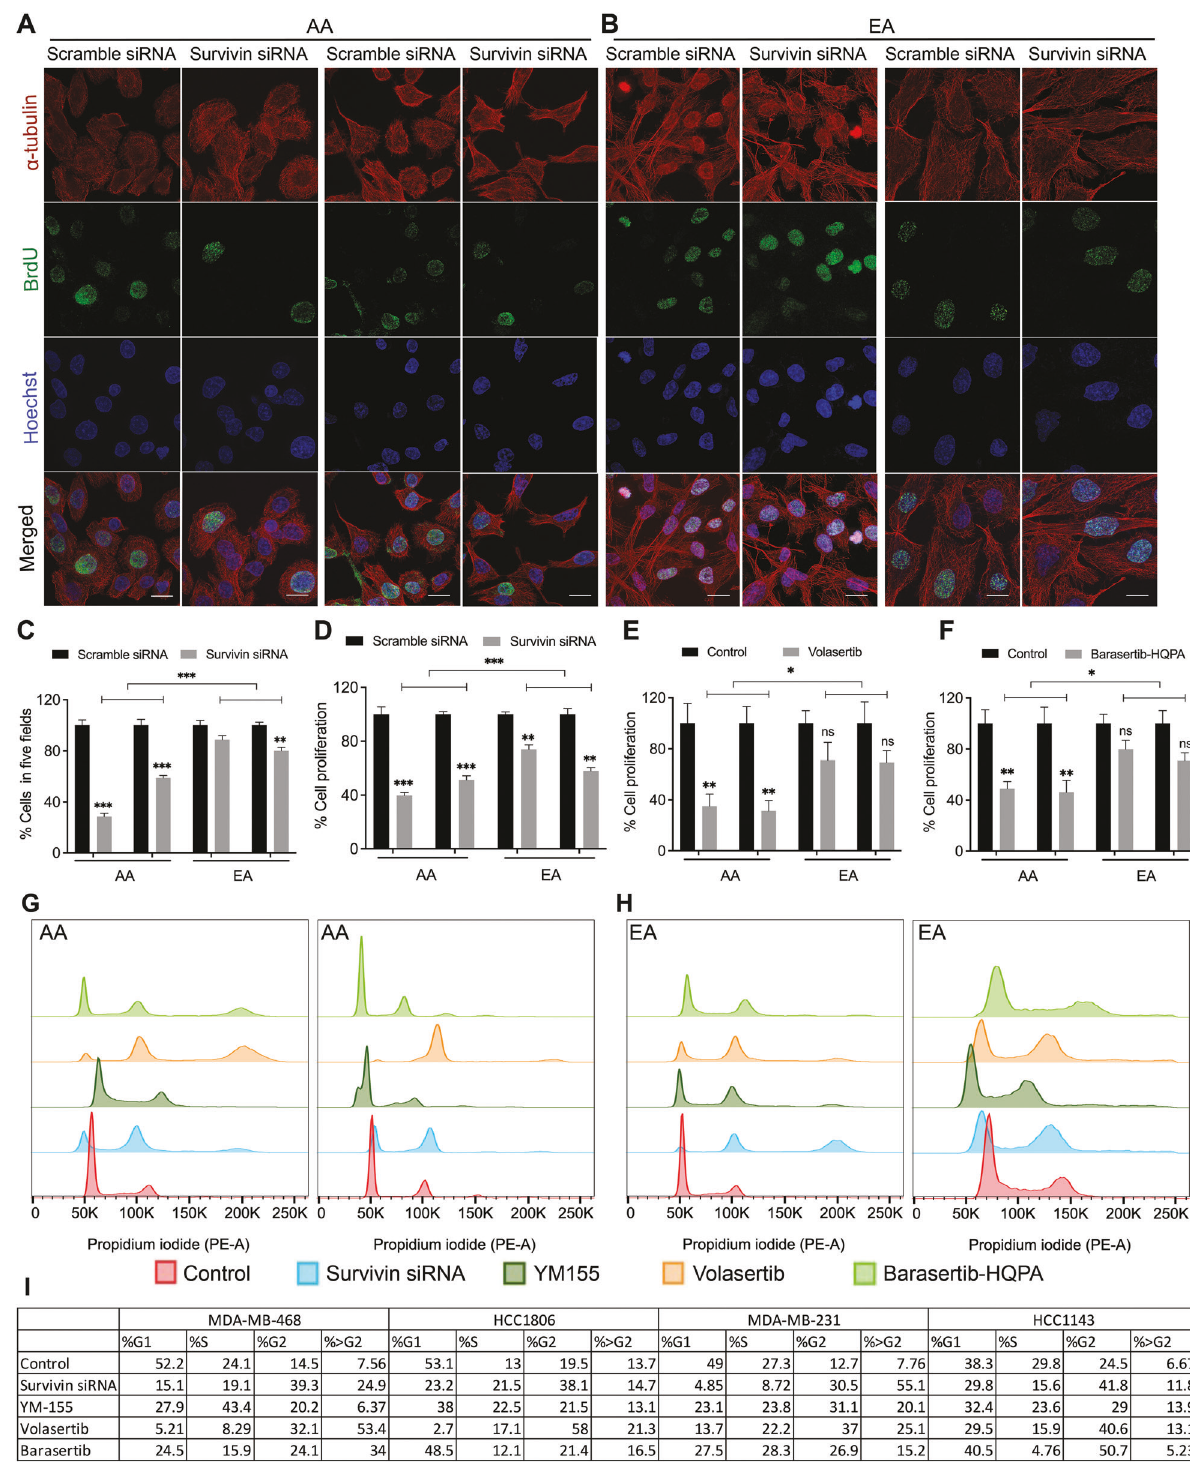
Fig. 4 Survivin is crucial for cell proliferation and cell cycle progression in AA TNBC cells. A – C Representative immuno fl uorescence images ( A , B ) and quanti fi cation bar graphs ( C ) showing BrdU (green) incorporation in various AA ( A ) and EA ( B ) TNBC cell lines transfected with scrambled or survivin siRNAs. Nuclei were counterstained with Hoechst (blue) and tubulin (red). D – F Bar graphs showing BrdU incorporation in AA and EA TNBC cells treated with survivin siRNA ( D ), volasertib ( E ), and barasertib-HQPA ( F ). Absorbance was measured at 450 – 540 nm. G – I Flow cytometry analysis depicting various cell cycle phases in AA ( G ) and EA ( H ) TNBC cells treated with control (red), survivin siRNA (light blue), YM155 (dark green), volasertib (orange), and barasertib (bright green) and their quanti fi cation ( I ). Data were analyzed using FlowoJo. Bars indicate mean ± SEM. Unpaired two-tailed Student ’ s t -test with Welch ’ s correction was used to determine statistical signi fi cance (* P < 0.05, *** P < 0.0005, ns = non-signi fi cant). The scale bar represents 10 µm.